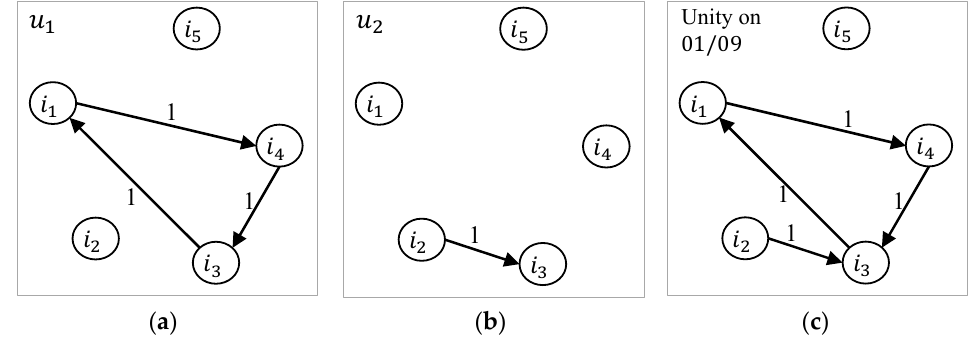
Figure 4. Construction of unity graph for A 1 on 9 January 2017. ( a ) A directed graph for u 1 on 9 January. ( b ) A directed graph for u 2 on 9 January. ( c ) A unity graph on 9 January.